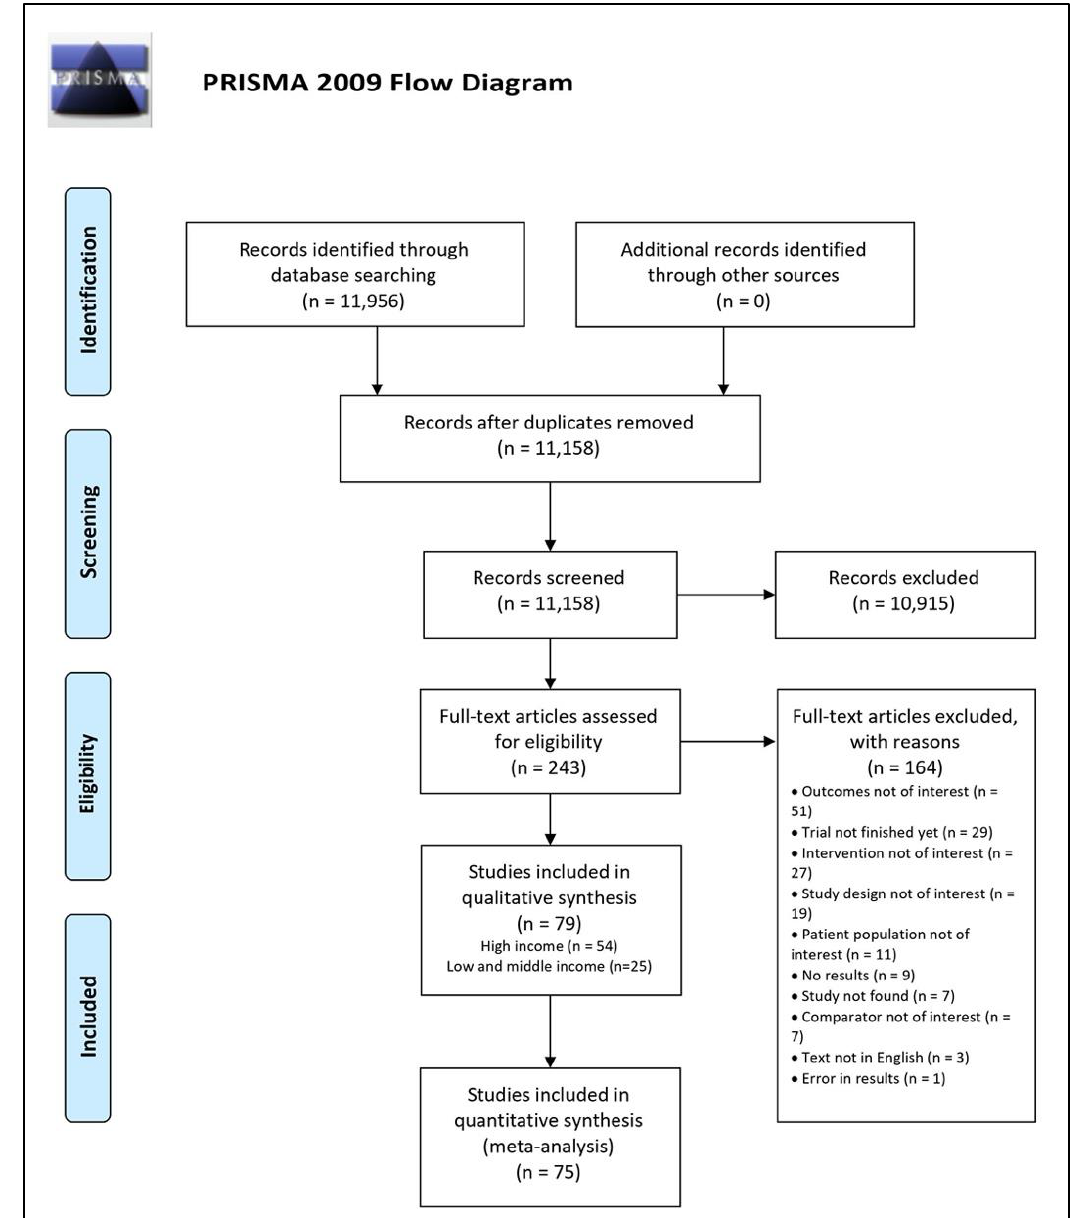
Figure 1. PRISMA Flow Diagram.